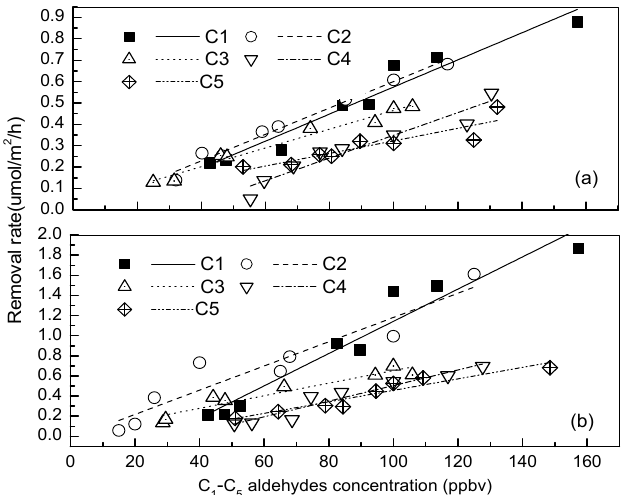
Figure 5. Relationship between the removal rate of C 1 –C 5 aldehydes of the two houseplant species and the C 1 –C 5 aldehydes concentration. ( a ) Schefflera octophylla (Lour.) Harms (R 2 = 0.778~0.979); ( b ) Chamaedorea elegans. (R 2 = 0.890~0.928) C 1 : Formaldehyde; C 2 : Acetaldehyde; C 3 : Propionaldehyde; C 4 : N-butyraldehyde; C 5 : Valeraldehyde. Significant differences for p < 0.05 are shown with least significant (LSD) test.